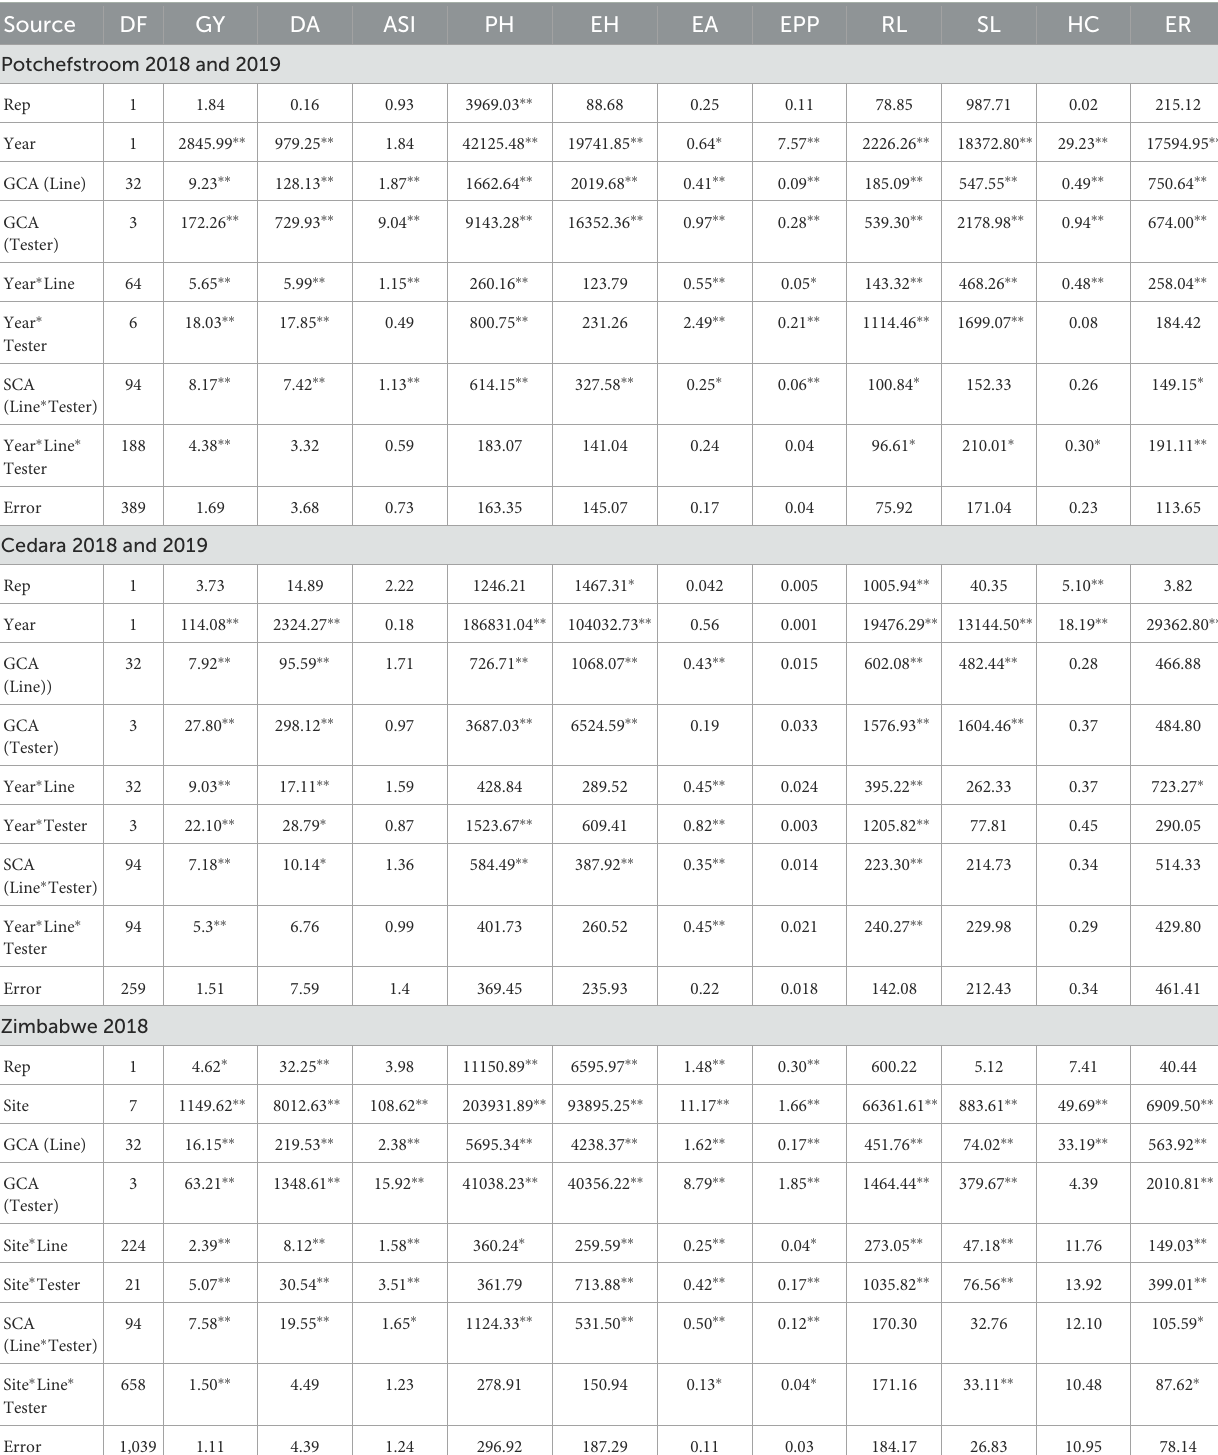
TABLE 1 Mean squares from analysis of variance for general and specific combining ability for grain yield and other agronomic traits of QPM lines at Potchefstroom, Cedara and Zimbabwe during the 2018 and 2019 cropping